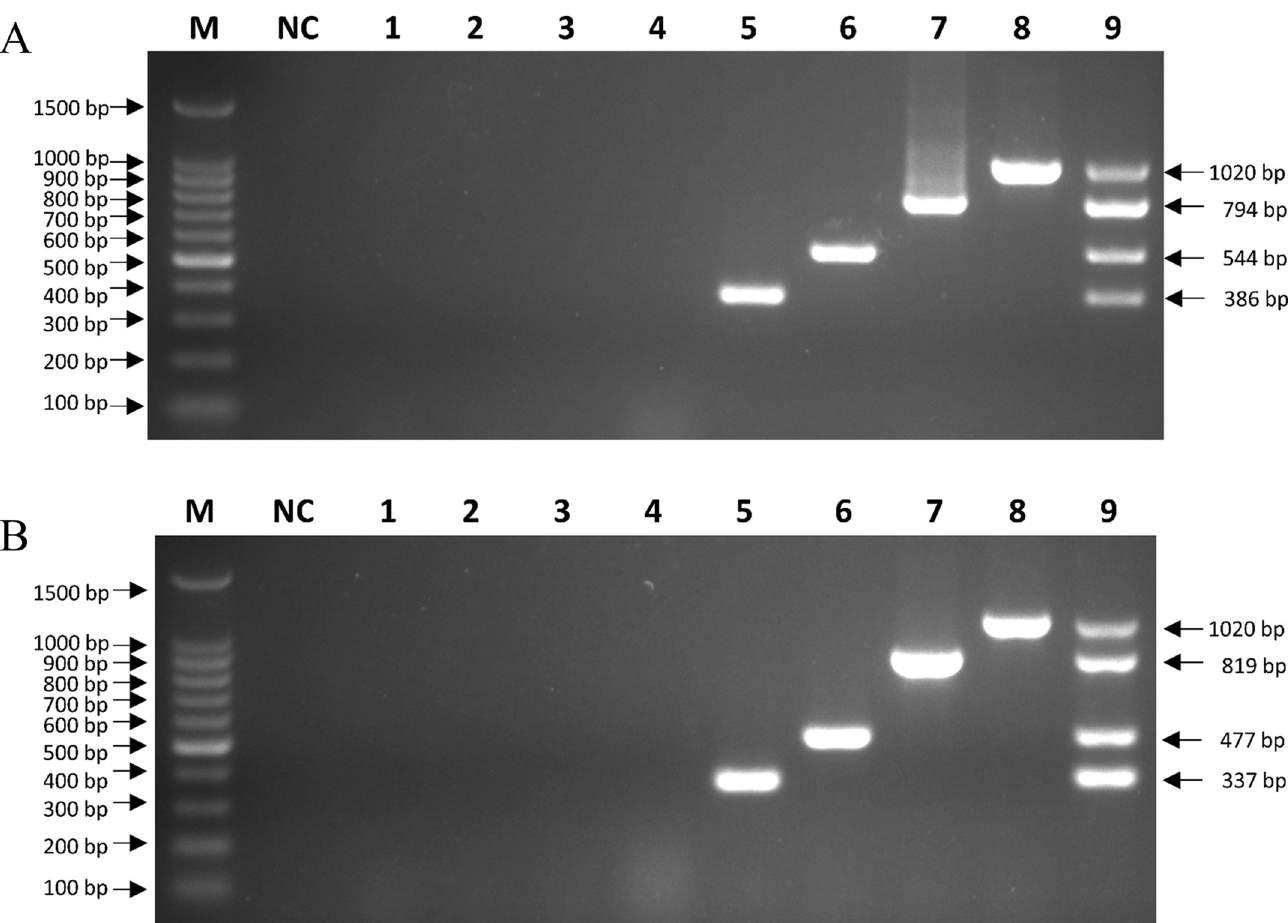
Fig 2. Specificity of the mPCR methods. Agarose gel electrophoresis (1.5%) of specific fragments amplified by mPCRs from the proviral DNAs and cDNA of MDCK cells, E . coli , Salmonella enterica and RABV. (A) CRV mPCR: Lane M, 100 bp DNA ladder; Lane NC, negative control; Lane 1, E . coli ; Lane 2, Salmonella enterica ; Lane 3, RABV; Lane 4, MDCK cells; Lanes 5~8, pMD-CPIV, pMD-CIV, pMD-CDV, and pMD-CAV-2; Lane 9, mixed standard of pMD-CPIV/ pMD-CIV/pMD-CDV/pMD-CAV-2 plasmids. (B) CEV mPCR: Lane M, 100 bp DNA ladder; Lane NC, negative control; Lane 1, E . coli ; Lane 2, Salmonella enterica ; Lane 3, RABV; Lane 4, MDCK cells; Lanes 5~8, pMD-CPV, pMD-CCoV, pMD-CanineCV, and pMD-CAV-2; Lane 9, mixed standard of pMD-CPV/ pMD-CCoV/pMD-CanineCV/pMD-CAV-2 plasmids.